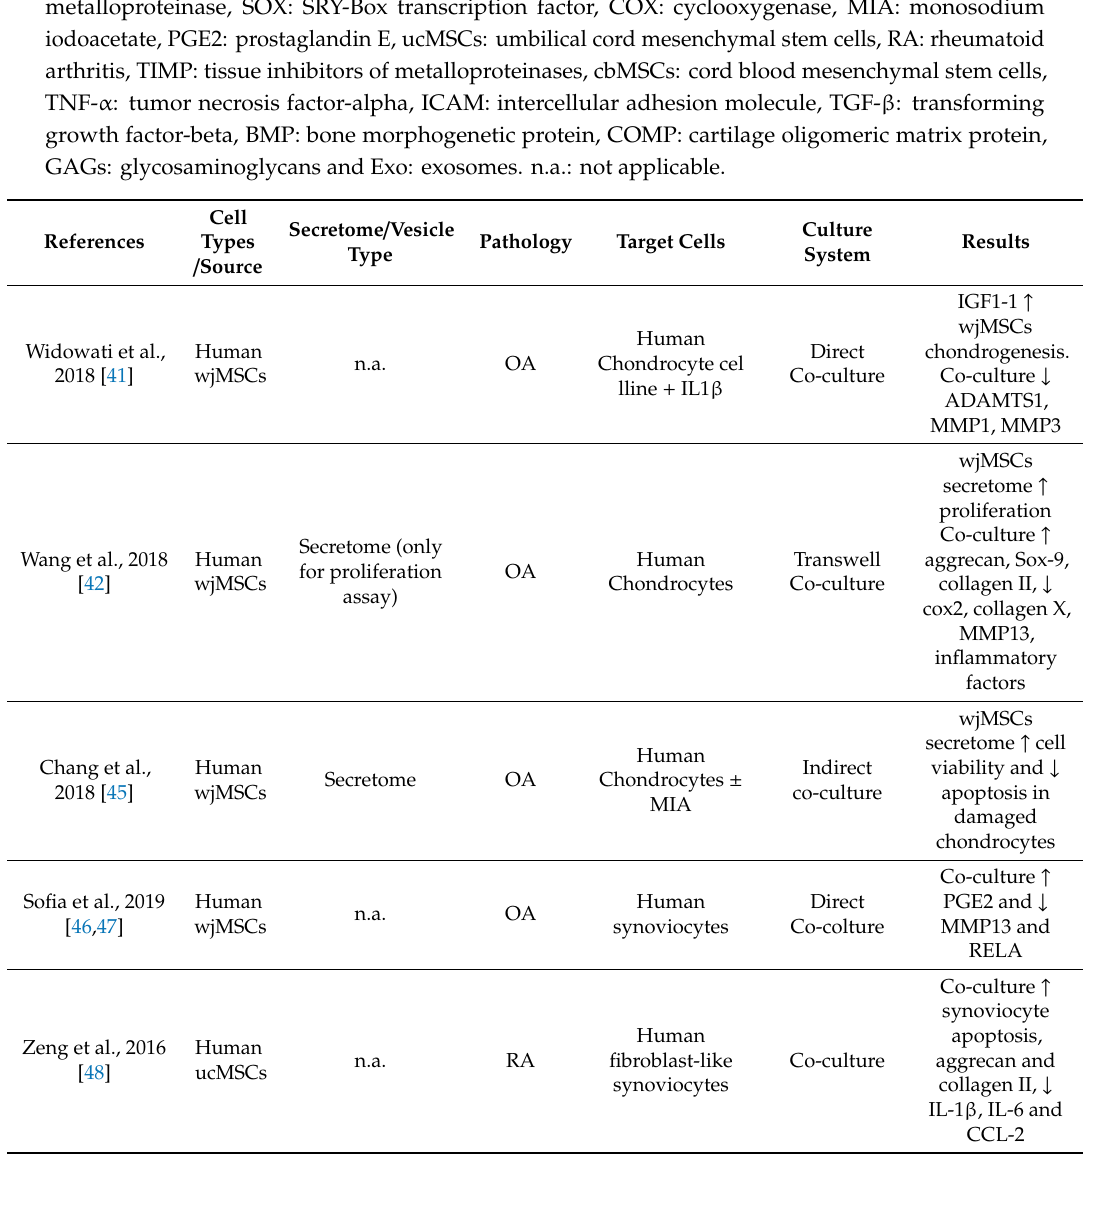
Table 1. Details of the studies that used mesenchymal stem cells (MSCs) from the umbilical cord or their secretome / extracellular vesicles (EVs) in the treatment of in vitro models of joint diseases.